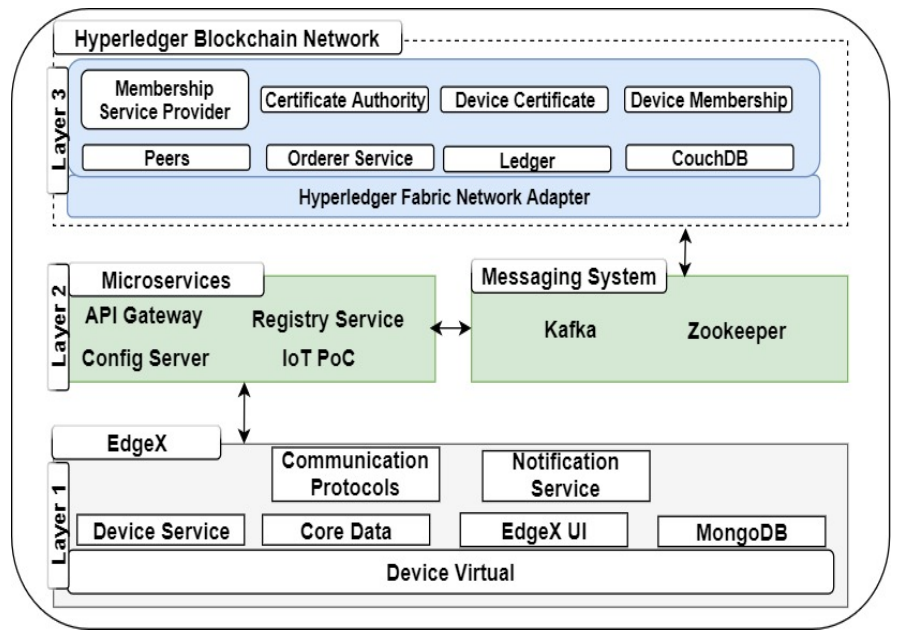
Figure 2. Proposed overall architecture.